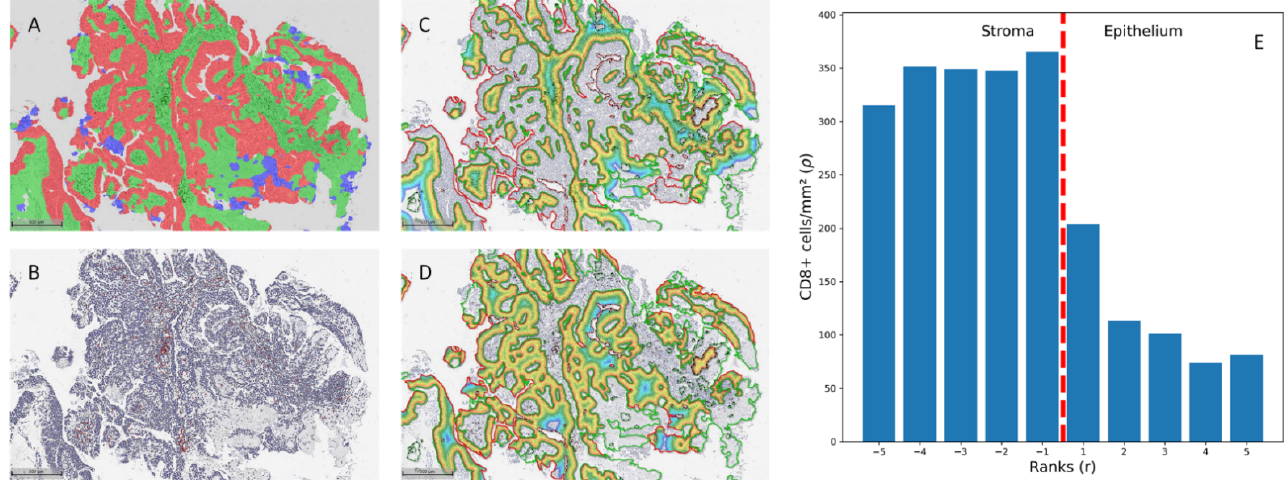
Figure 1. ( A ). Tissue classification results. ( B ). Cell classification results. ( C , D ). Infiltration analysis was performed on stromal and epithelial compartments. The 500 µm measures were added for ref- erence. ( E ). CD8+ cell density distribution by ranks in an example case. reference. ( E ). CD8+ cell density distribution by ranks in an example